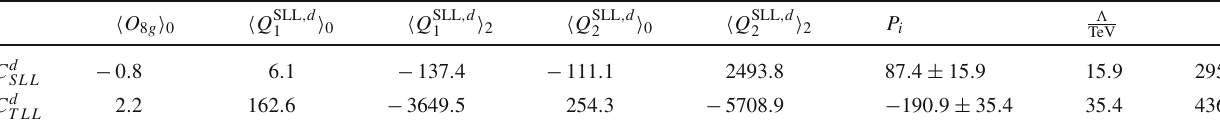
Table 9 Coefficients p ( I ) and P i of the master formula (18)–(19) as well as suppression scale (cid:8) (last column) from RLRL type operators of Class ij D with flavour structure ( ¯ sd )( ¯ dd )